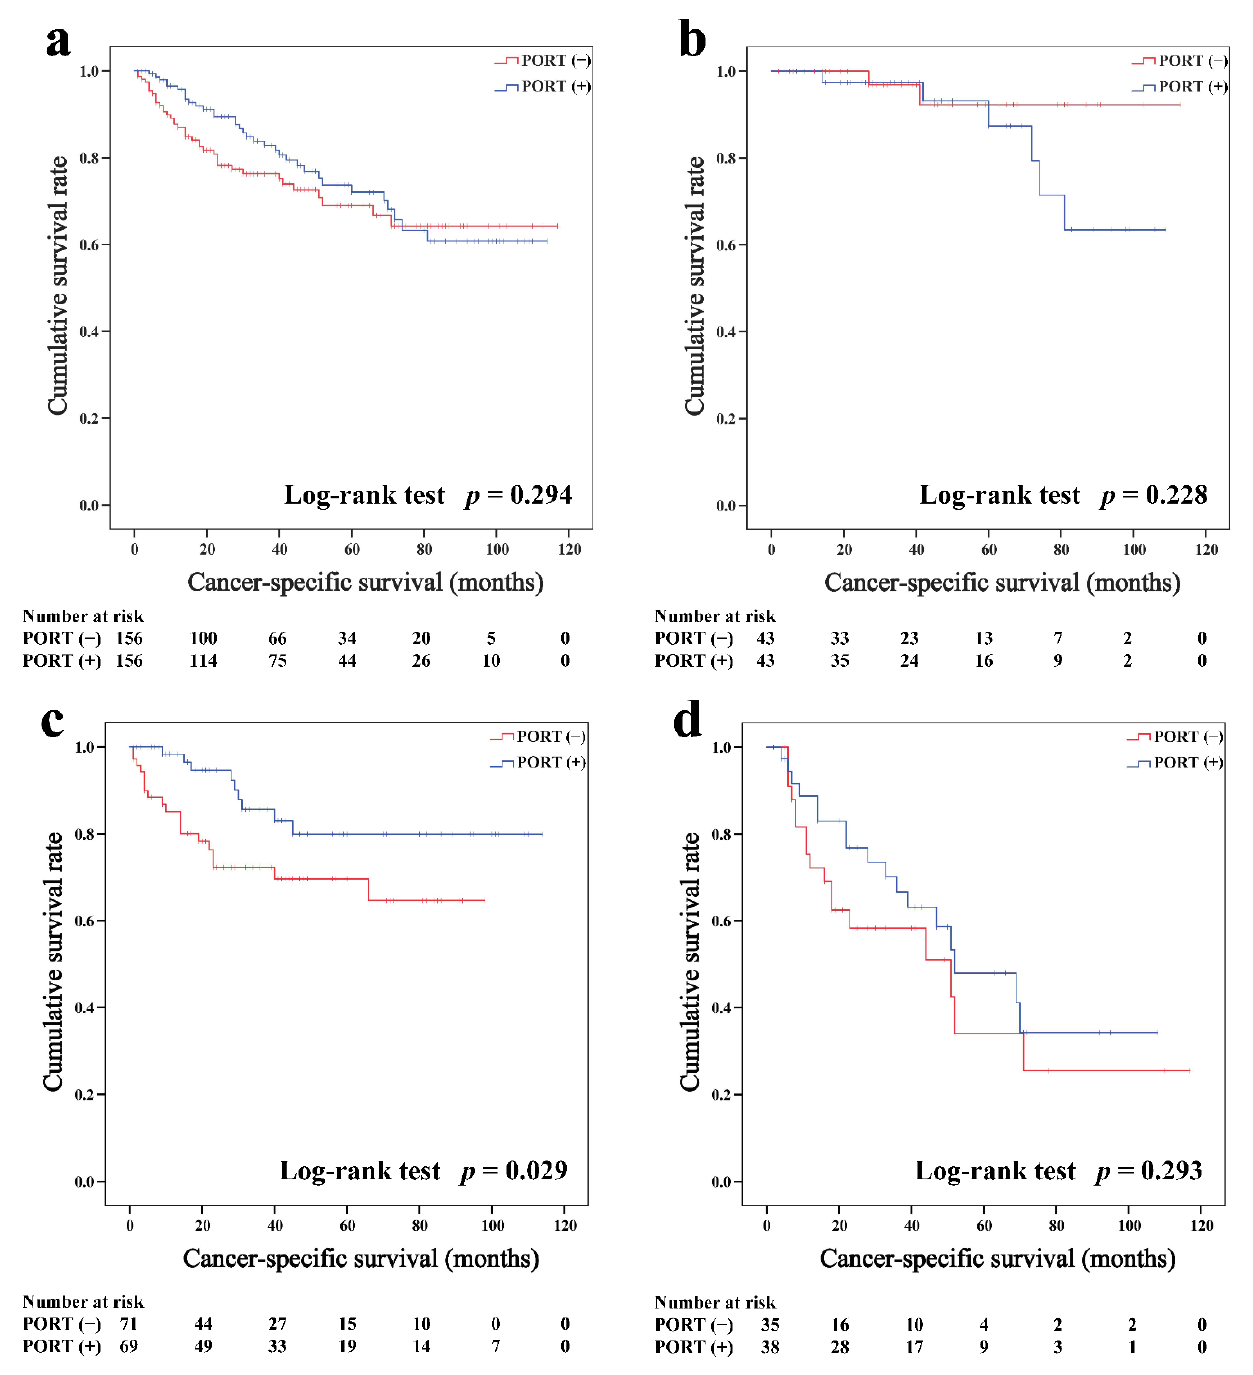
Figure 5. Cancer-specific survival in all ( a ), Masaoka-Koga stage I–IIA ( b ), IIB ( c ), and III–IV ( d ) thymic carcinoma patients.